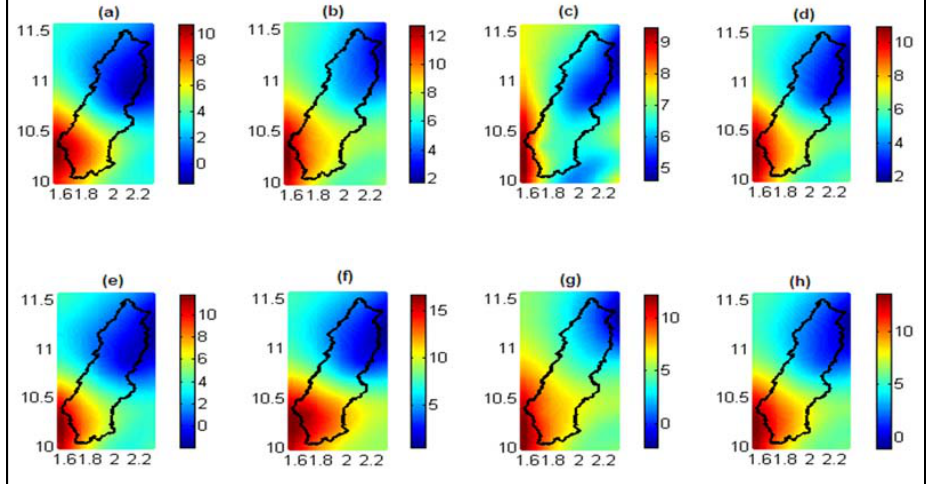
Figure 9 : Changes in the lengths of the dry spells (%) compared to the reference period: a : RCP4.5 ‐ 2011–2040; b : RCP4.5 ‐ 2041–2070; c : RCP4.5 ‐ 2071–2100; d : RCP4.5 ‐ 2011–2100; e : RCP8.5 ‐ 2011–2040; f : RCP8.5 ‐ 2041–2070; g : RCP8.5 ‐ 2071–2100; h : RCP8.5 ‐ 2011 ‐ 2100.